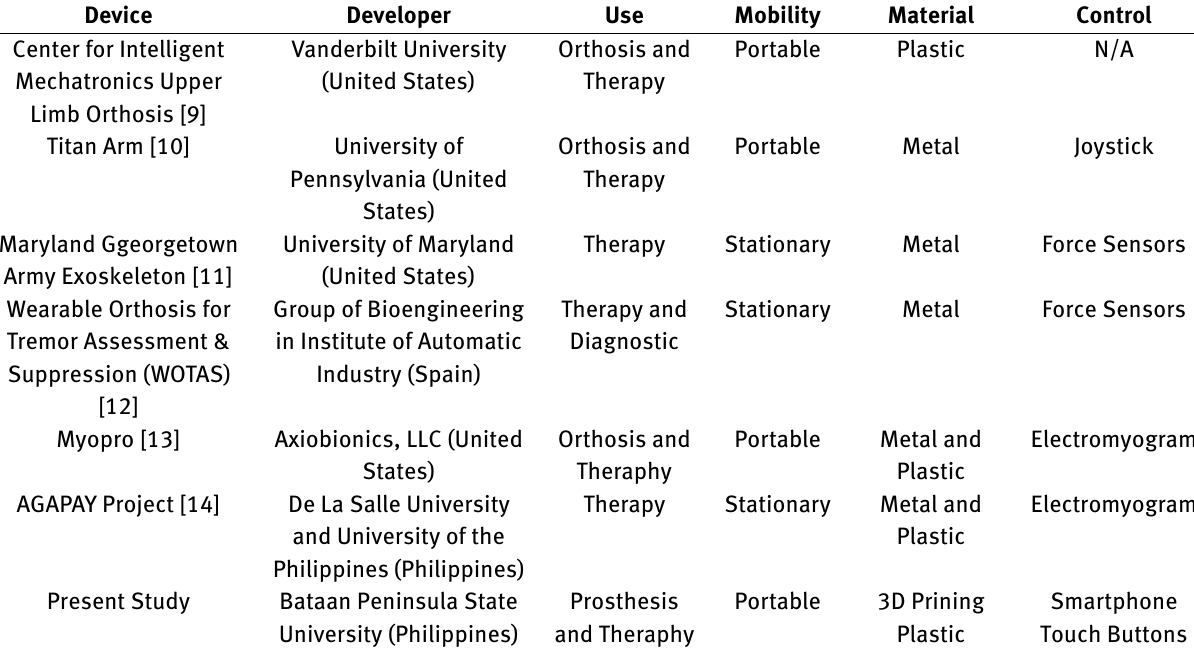
Table 2: Comparison of different devices and existing studies for arm therapy and orthosis